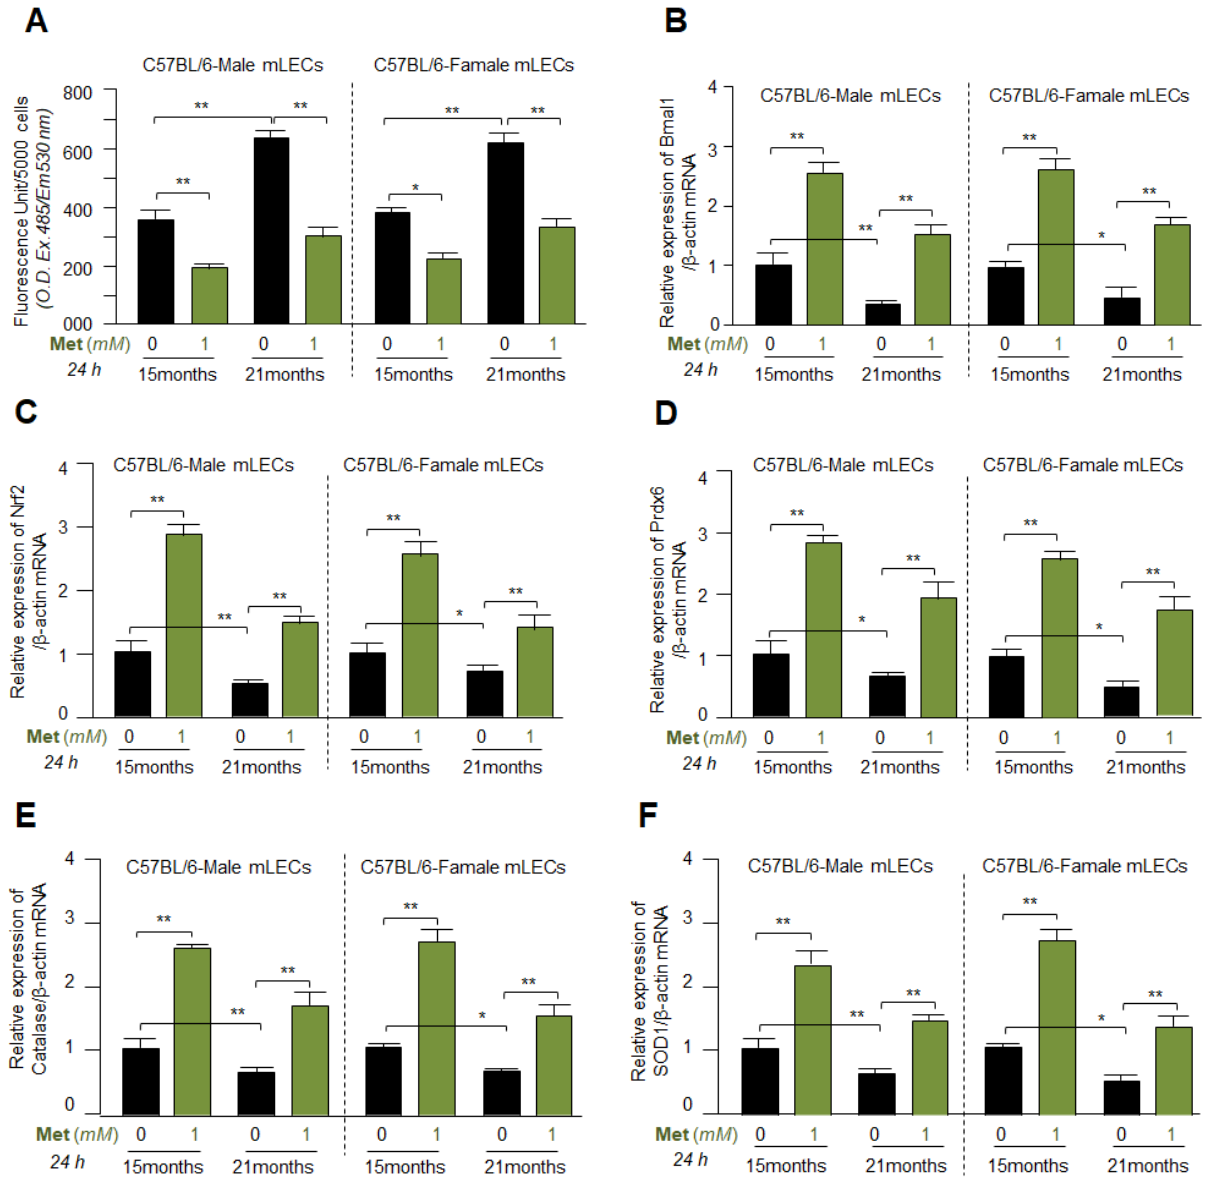
Figure 8. Primary mLECs isolated from C57BL/6 male or female mice revealed significantly reduced ROS level with increased expression of Bmal1 and Nrf2 and target antioxidants, Prdx6, Catalase and SOD1 in response to Metformin. Primary mLECs (5 × 10 4 ) isolated from C57BL/6 male and female mice were cultured in 12-well culture plate and treated with Metformin for 24 h as shown in figure. ( A ) Increased ROS levels during aging was mitigated by Metformin treatment. ROS levels were measured using H2-DCF-DA dye methods. The histograms represent the mean ± S.D. from three independent experiments. Untreated vs. Metformin-treated; * p < 0.05; ** p < 0.001. ( B – F ) Total RNA isolated from Metformin-treated primary mLECs-derived from C57BL/6 mice of both sexes was subjected for mRNA analysis of Bmal1 and Nrf2, and their target antioxidant gene, Prdx6, Catalase and SOD1 with their specific primers as shown in Table 1. The data represent the mean ± S.D. from three independent experiments. Untreated vs. Metformin-treated; * p < 0.05; ** p <